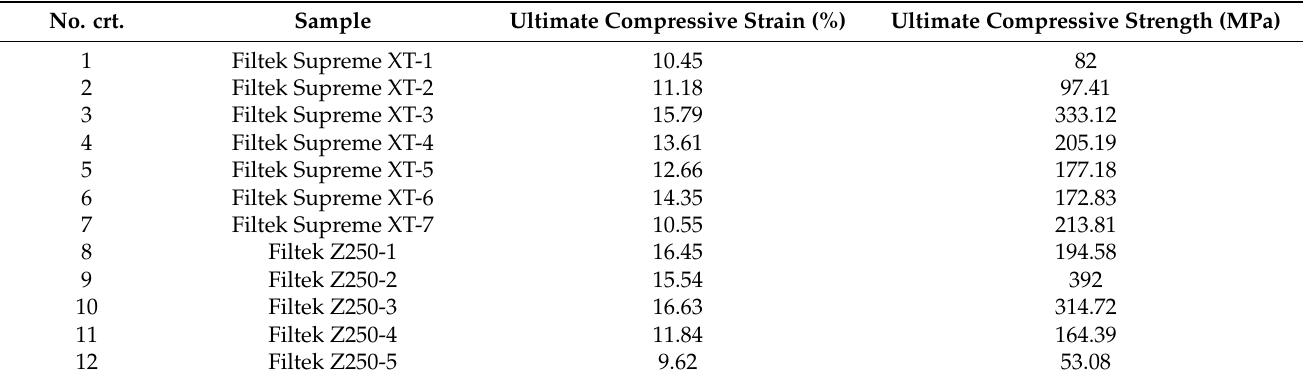
Figure 2. Variation of compressive strain with compressive stress for Filtek Z250 composite specimens. All the samples showed high compressive strength; the experimental values obtained are shown in Table 1, reaching maximum forces in the order of thousands of newtons. Table 1. Experimental values of shear strain and compressive strength for Filtek Supreme XT and Filtek Z250 composite specimens.